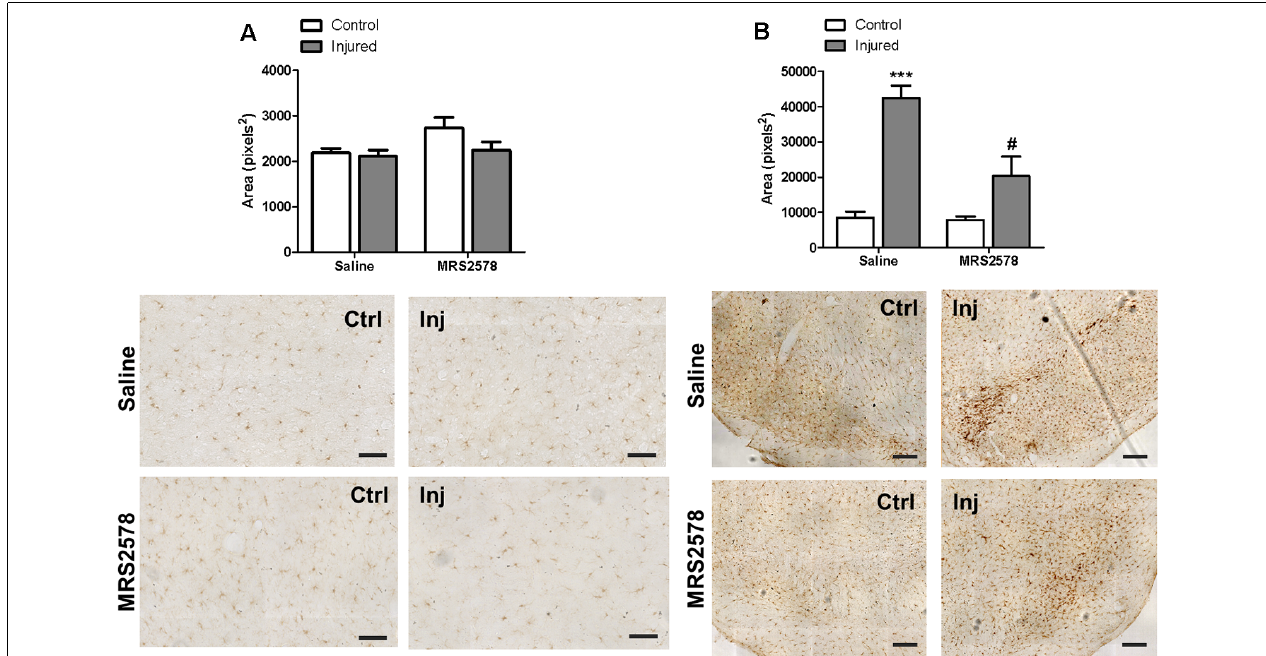
FIGURE 6 | Immunohistochemical analysis of Iba-1 labeling in striatum and substantia nigra of animals treated by intrastriatal injection of 2 µ g/kg MRS2578 10 min prior to 6-OHDA injection. (A) Striatum , scale: 100 µ m, F ( 1,20 ) = 1.276, p = 0.272; and (B) substantia nigra , scale: 200 µ m, F ( 1,20 ) = 26.7926, p < 0.001. The area marked with Iba-1 in the control (Ctrl) and injured hemispheres (Inj) are expressed as mean ± standard error of the mean (SEM). n = 6 for each group. ∗∗∗ p < 0.001, in relation to the respective control hemisphere; # p < 0.05 in relation to injured hemisphere from saline group. Two-way ANOVA followed by the Bonferroni post hoc